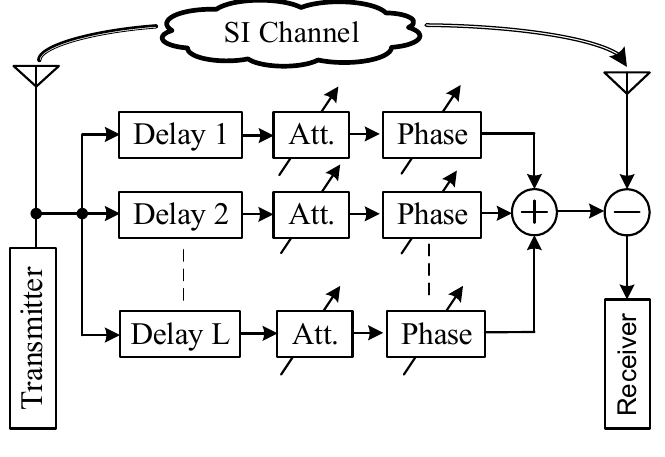
Figure 1. Multi-tap adaptive filter